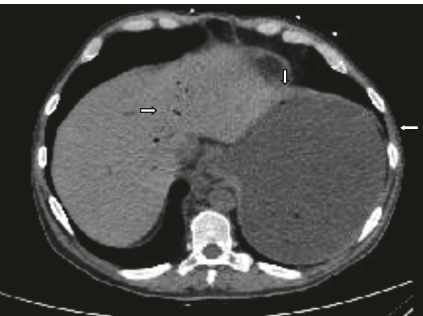
Figure 1: Abdominal CT scan showing stomach distension and limited gas within the wall of the stomach and in the portal venous system.